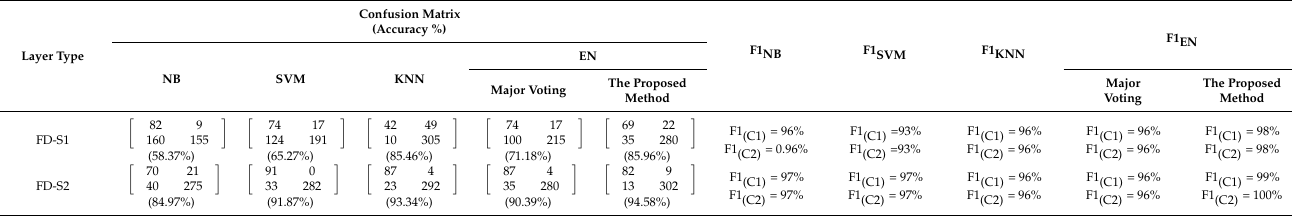
Table 7. Validation results of the FD layer.